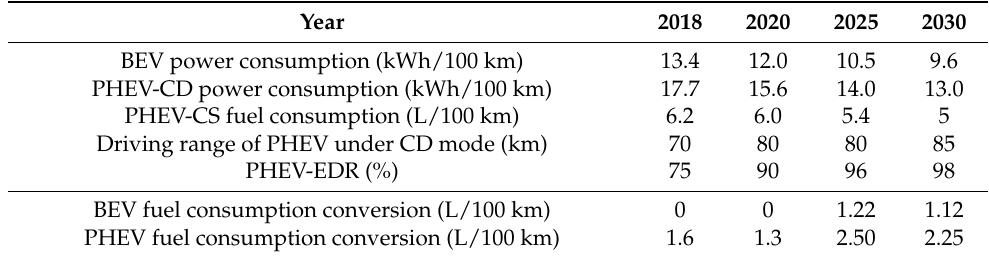
Table 3. Power consumption and conversion fuel consumption of NEV. PHEV-CD: charge depleting mode of plug-in hybrid electrical vehicle. PHEV-CS: charge sustaining mode of Plug-in hybrid electrical